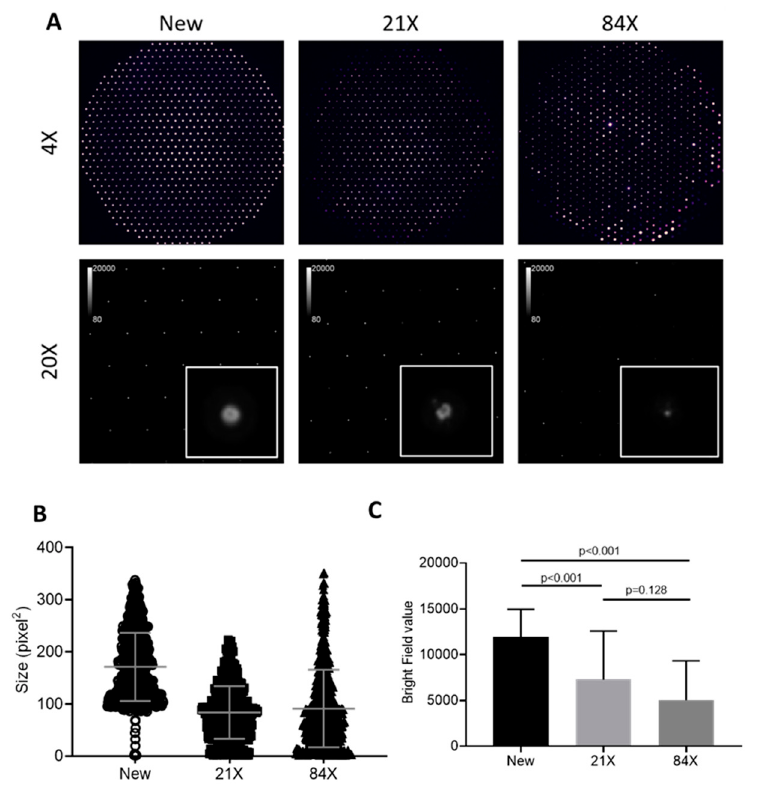
Figure 4. ( A ) Aperture plates with magnification 4 × and 20 × of three conditions, ( B ) total size of the opening area, and ( C ) intensity measurement of light penetrated through the mesh.